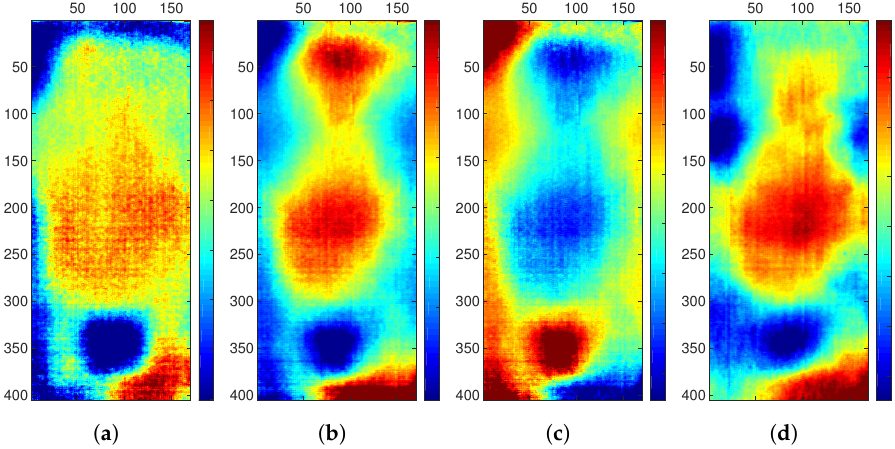
Figure 8. PCT analysis (EOF3); experiment 1. ( a ) Setup 1 (best result). The cavity is located exactly under the blue square patch at the bottom of image. ( b ) Setup 2. ( c ) Setup 3. ( d ) Setup 4. Input: cooling down frames for Setup 1, 3, 4 and the entire image sequence for Setup 2. Heating up period: 5 s for Setup 1–3 and 25 s for Setup 4. Temporal filtering was applied only in setup